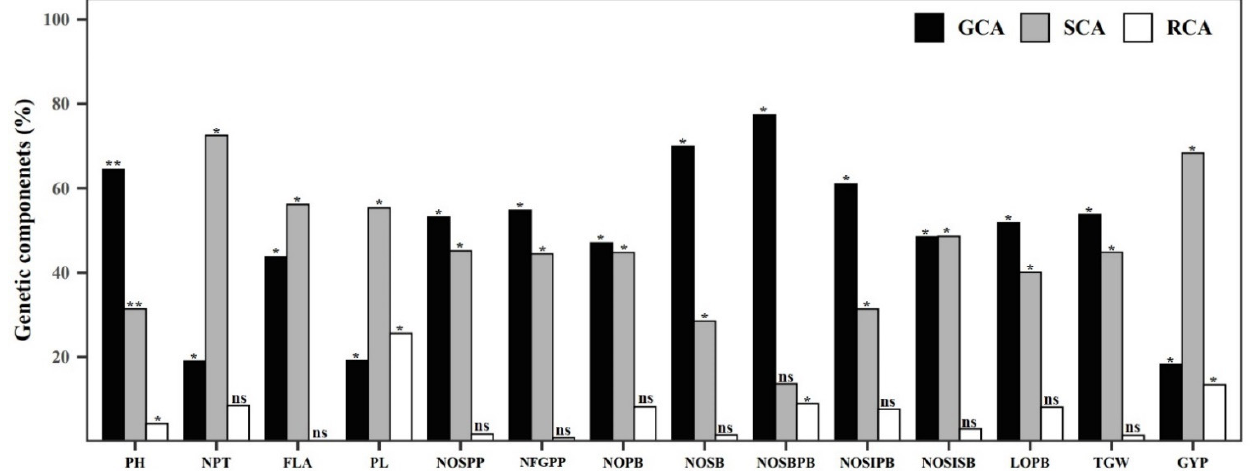
Figure 6. Percentage of genetic components present in fourteen panicle- and yield-related traits estimated by Griffing’s diallel analysis method I model I. * and ** indicates 5% and 1% significant difference from average compared to the Student’s t -test, ns indicates not significant.